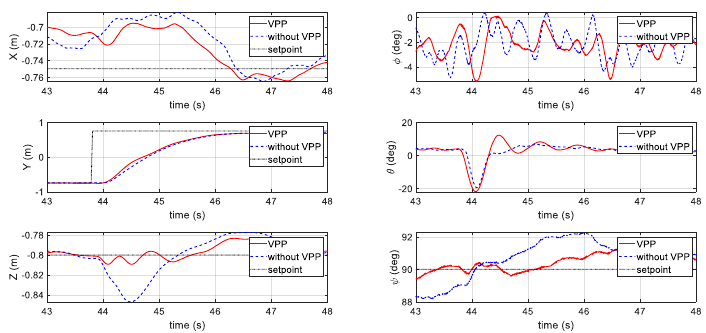
Figure 14. Results of the second flight test scenario with a step command with and without VPP.